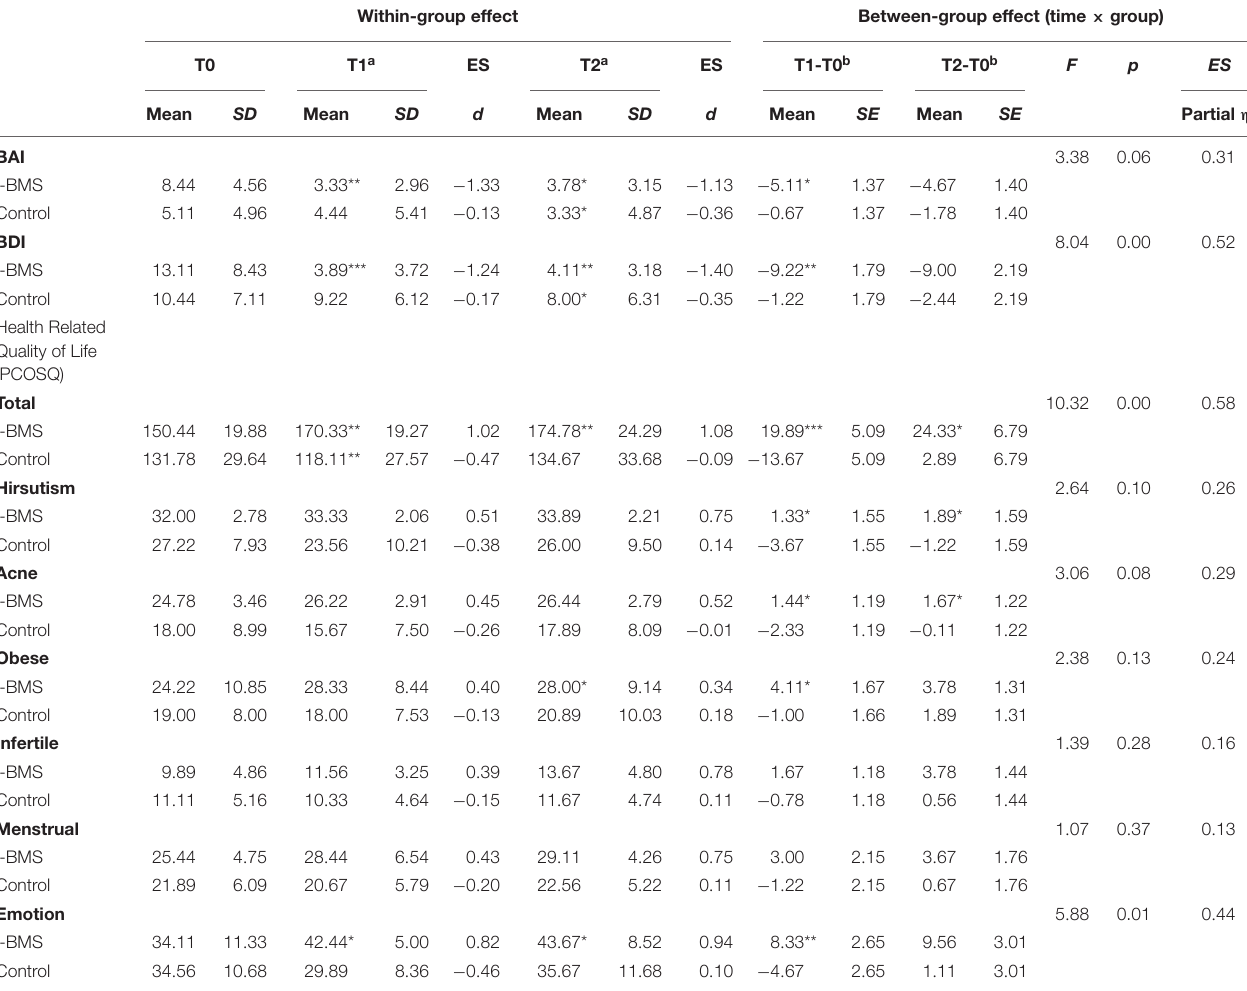
TABLE 3 | Anxiety, depression and health-related quality of life at study time points (Intention-to-treat analysis, n = 18). Within-group effect Between-group effect (time ×